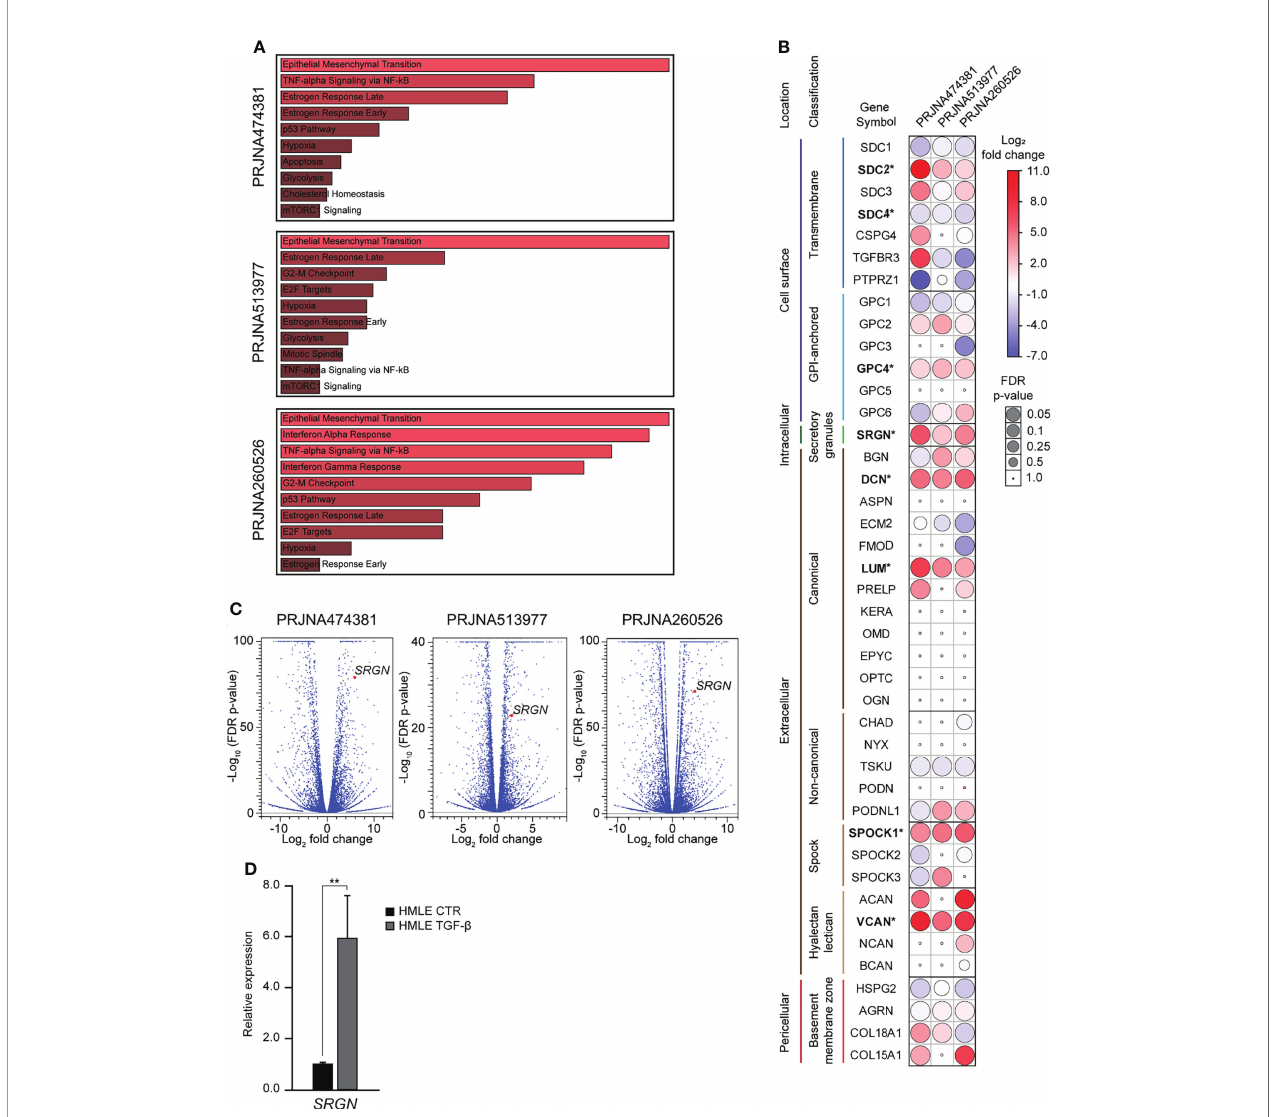
FIGURE 1 | Serglycin is transcriptionally upregulated during TGF- b induced epithelial-mesenchymal transition. (A – C) Analysis of RNA-Seq data from three publicly available data sets. (A) Gene set enrichment analysis for differentially expressed genes. Length and color represent the signi fi cance of that speci fi c gene-set. (B) Expression of 42 genes encoding proteoglycans. Bold gene symbols marked with * were de fi ned as differently expressed in all three datasets and with the same direction of change. Color (blue-white-red) symbolizes fold change, while the size of circles symbolizes false discovery rate (FDR) corrected p-value. (C) Volcano plot including all analyzed genes. SRGN is marked as a red dot in all three plots. (D) RT-qPCR data showing SRGN expression in TGF- b induced HMLE cells. The experiment includes three biological replicates and is representative for one of a minimum of three independent experimental setups. Error bars represent standard deviation. (**p ≤